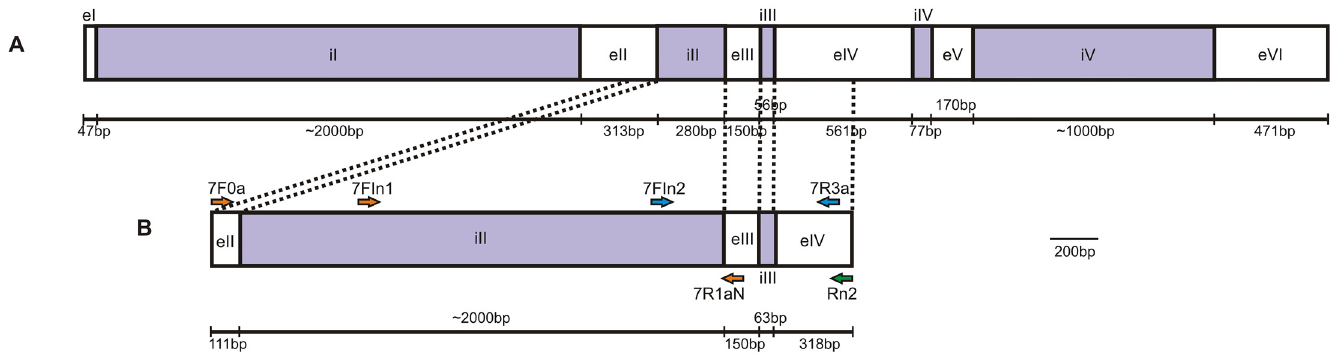
Fig 1. Carboxylesterase E3 Ch α E7 schematic view. Comparison of exon and intron lengths and position between (A) L . cuprina and (B) C . hominivorax . Exons and introns were named according to L . cuprina (e = exon; I = intron) [27]. The position of primers used for gene region characterization (7F0a, RN2, 7FIn1 and 7R1aN) and for posterior populational analyses (7FIn2, RN2 and 7R3a) are indicated by blue and red arrows, respectively. RN2 is indicated by a green arrow (used for both characterization and population